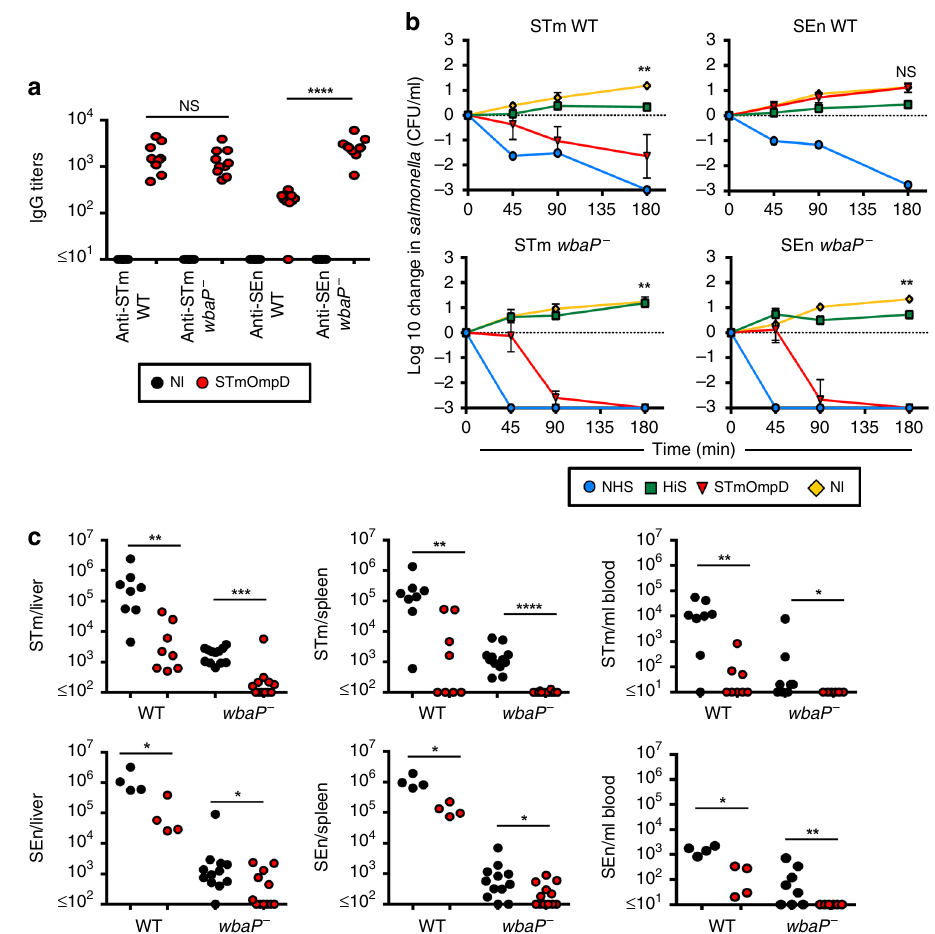
Fig. 3 Loss of O-Ag from SEn enhances protection by anti-STmOmpD antibodies. a IgG titers to STm and SEn WT and O-Ag-de fi cient mutants in sera from NI mice and mice immunized with STmOmpD. b Serum bactericidal assays using STm D23580, SEn D24954, and STm and SEn wbaP − mutants with sera from NI mice or mice immunized as in Fig. 1a, supplemented with human sera as a complement source with anti-STm-speci fi c antibodies depleted. Normal human serum (NHS, blue) and heat-inactivated human serum (HiS, green) were used as controls. Negative values correspond with a decrease in viable STm compared with starting normals. Samples were taken at minutes 45, 90, and 180 using a starting concentration of 10 6 CFU/ml. Sera from NI (yellow) and STmOmpD immune (red) WT mice were tested. c NI mice and mice immunized twice with 20 μ g of STmOmpD were challenged with 1 × 10 5 of STm or SEn (WT or wbaP − ) for 24 h, and bacterial burdens determined from the spleen, liver, and blood. Each point represents the titers from one mouse. Data are from three different experiments. * P ≤ 0.05, ** P ≤ 0.01, *** P ≤ 0.001, **** P ≤ 0.0001, NS = nonsigni fi cant assessed by two-tailed Mann – Whitney U